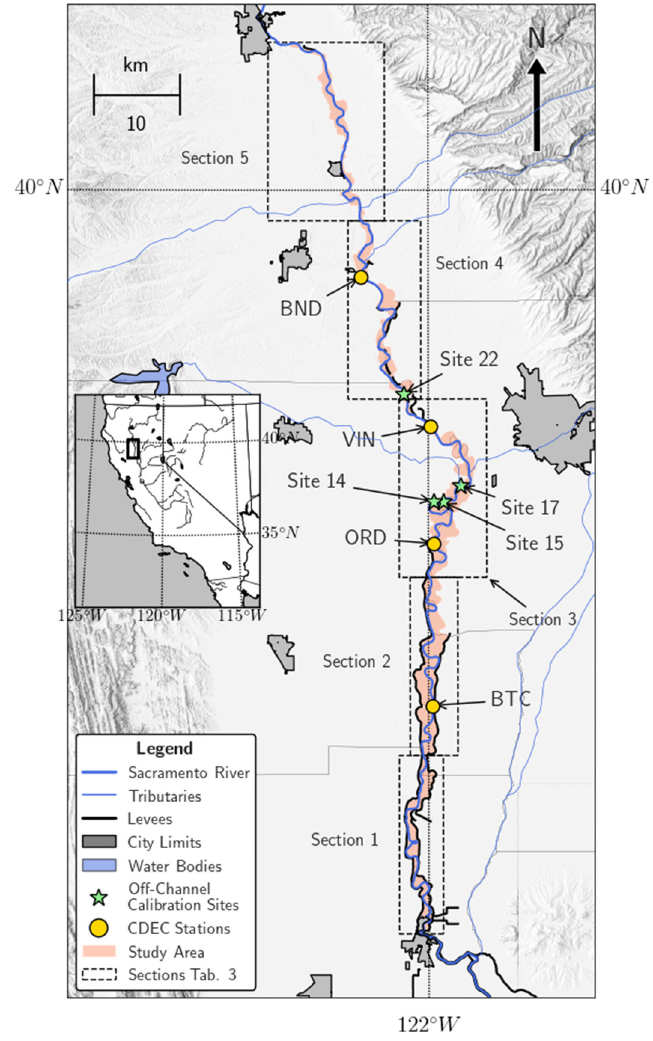
Figure 1. Middle Sacramento River from Red Bluff to Colusa. Two sets of remotely sensed imagery covering the area of interest were retrieved from Google Earth Engine catalog [47]: (1) Time-series of USGS LandSat-8 Surface Reflectance